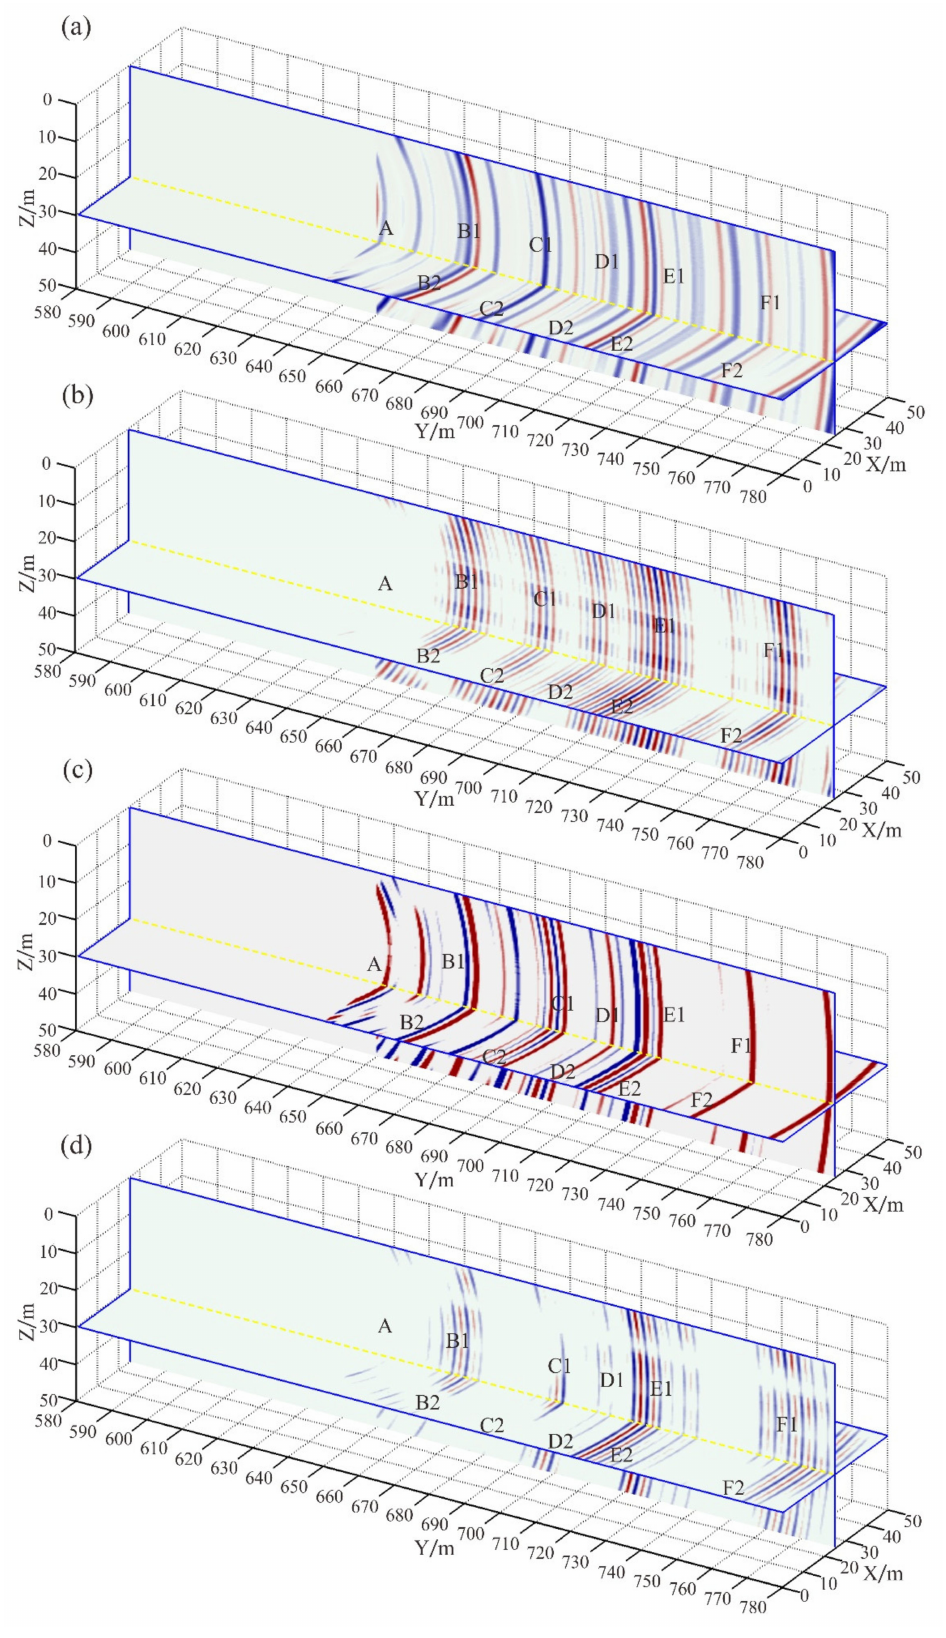
Figure 14. 3-D migration profile: ( a ) single-component Kirchhoff migration profile; ( b ) single- component RTM profile; ( c ) multi-component Kirchhoff migration profile; ( d ) multi-component RTM